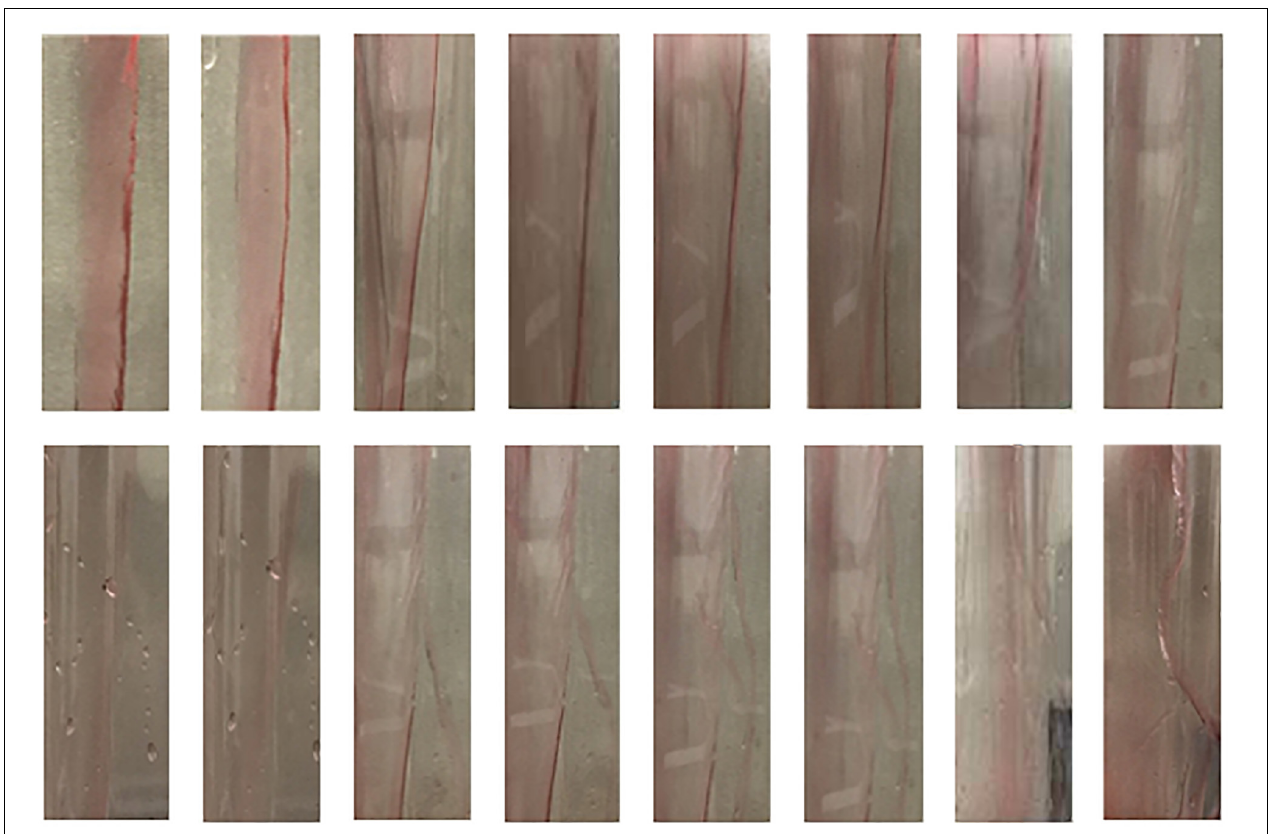
FIGURE 2 | Image of liquid film rupture (LFR) characteristics and process on corrugated plate dryer (CPD) wall.